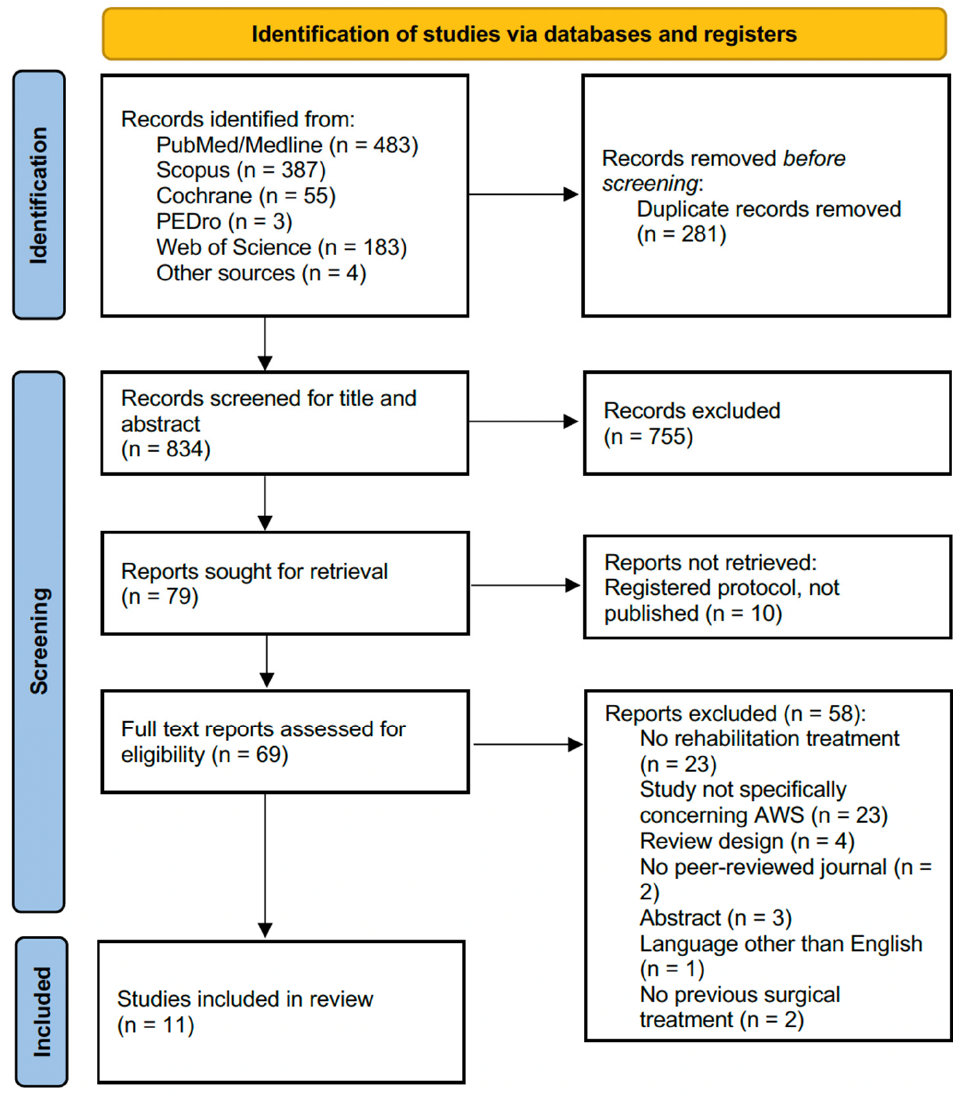
Figure 1. PRISMA 2020 flow chart.